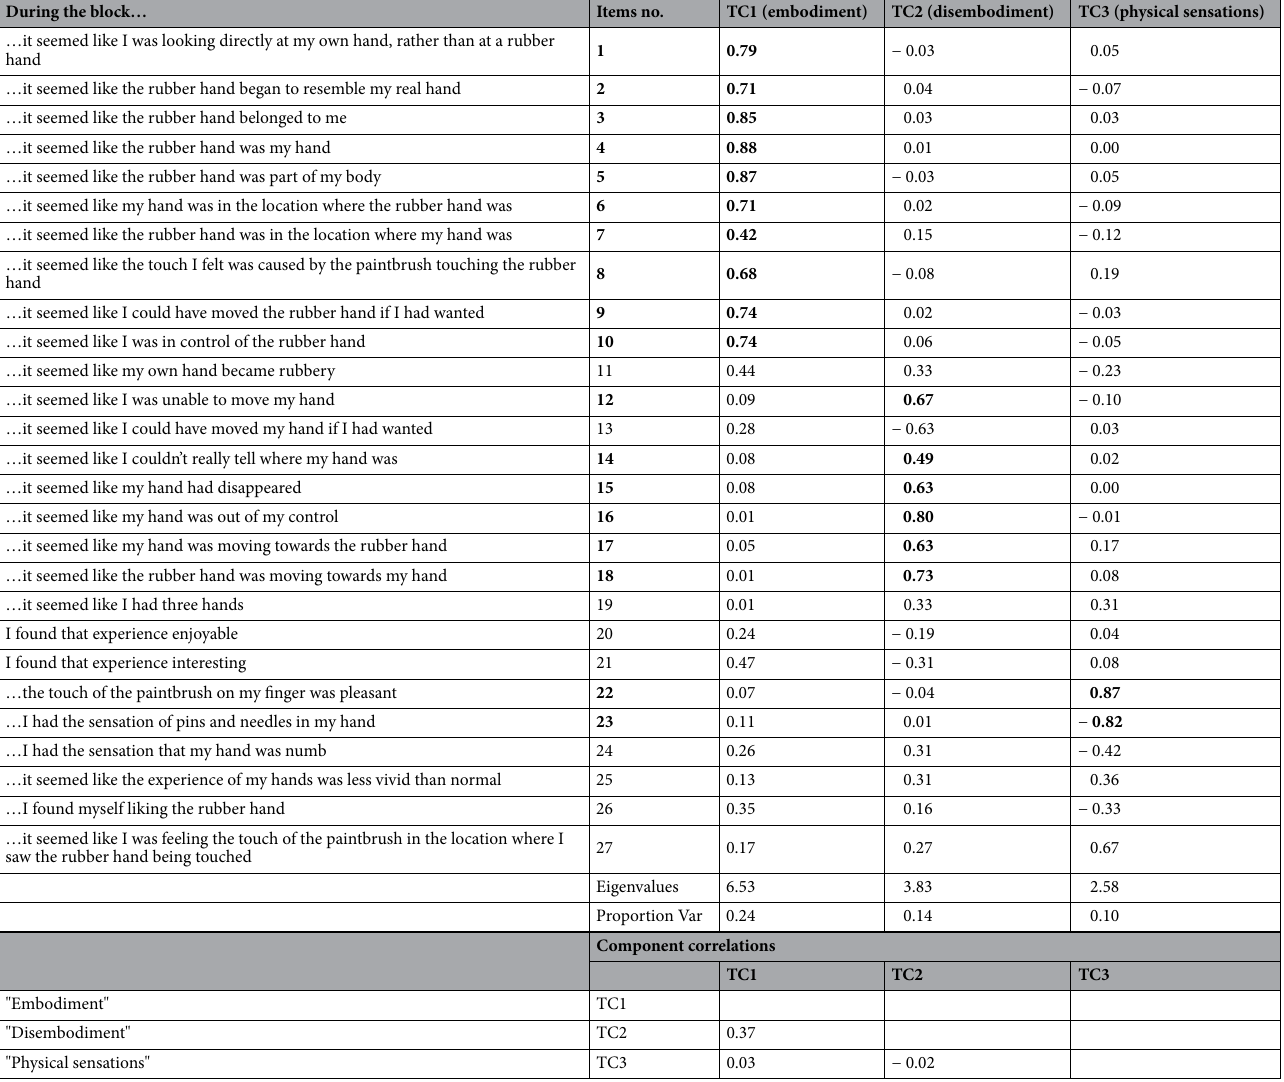
Table 1. Matrix of loadings, variance explained by the components, and their correlations. Among the questionnaire items reported in the first column, those in bold are included in the embodiment Scale. See also the Supplementary Material for a model form of the embodiment